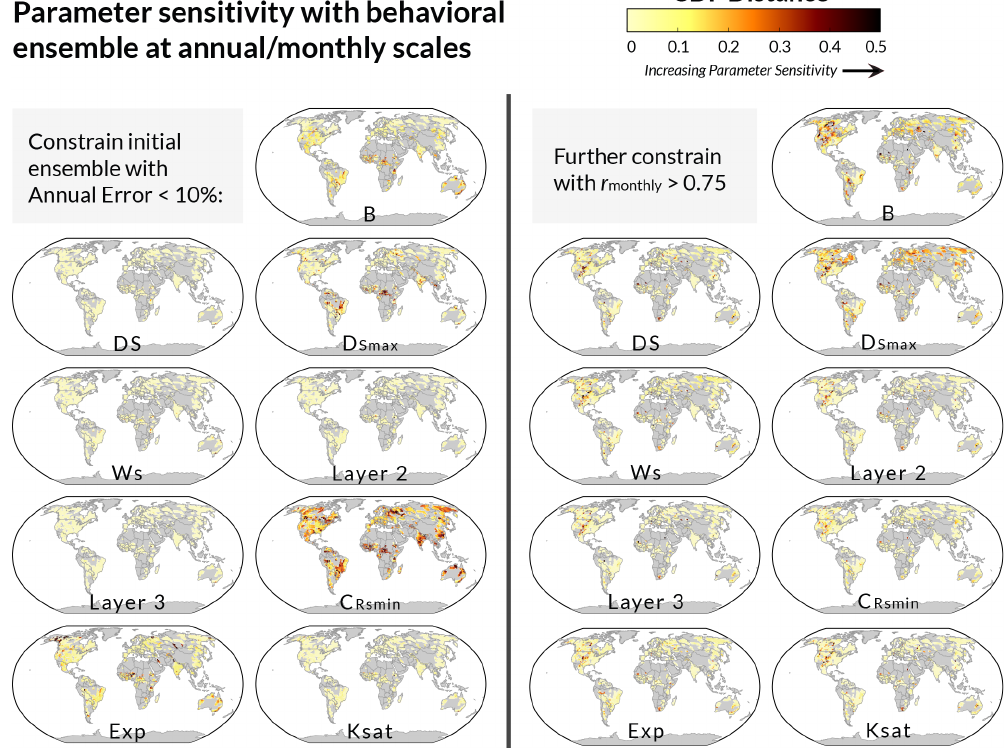
Figure 4. Global maps of the sensitivity of each VIC parameter used in the 10000 Latin hypercube sample simulations. The CDF distance is calculated for each VIC parameter after applying the annual error constraint (left) and again after applying the monthly correlation constraint (right).